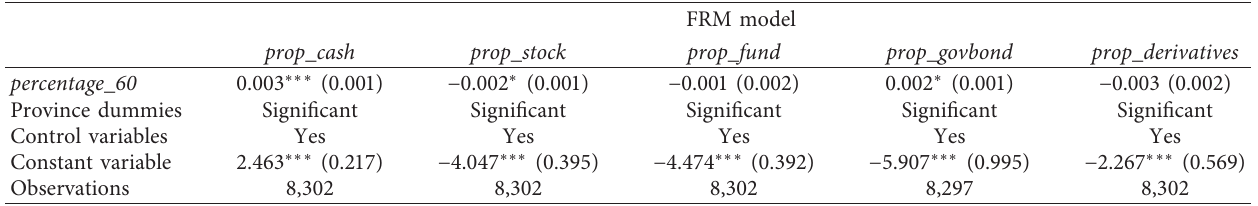
Table 10: Results on the proportions of different types of financial